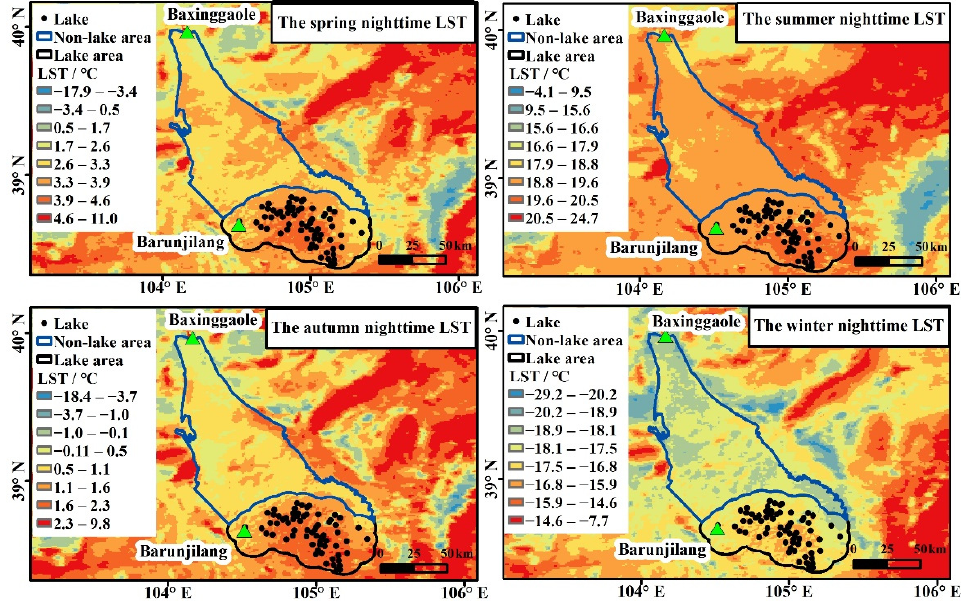
Figure 4. Distributions of average LST during the nighttime in the lake and non-lake